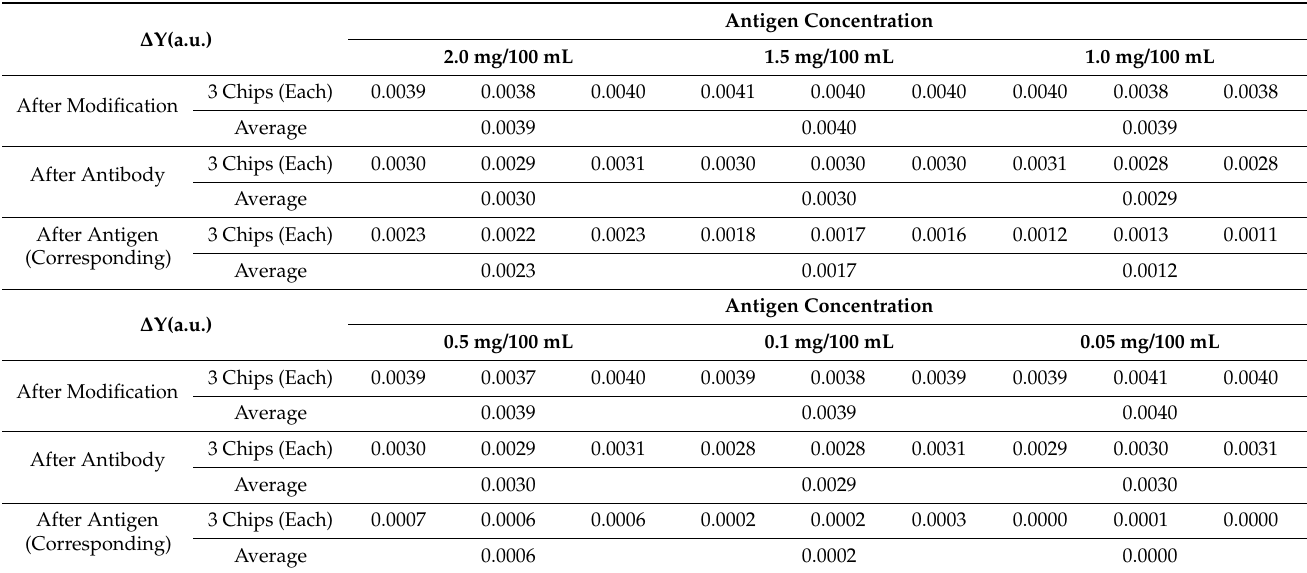
Figure 7. Resonance curve of troponin antigen experiment by TeraPulse. Table 1. Y -axis resonance position variation in troponin antigen ( ∆ Y) by